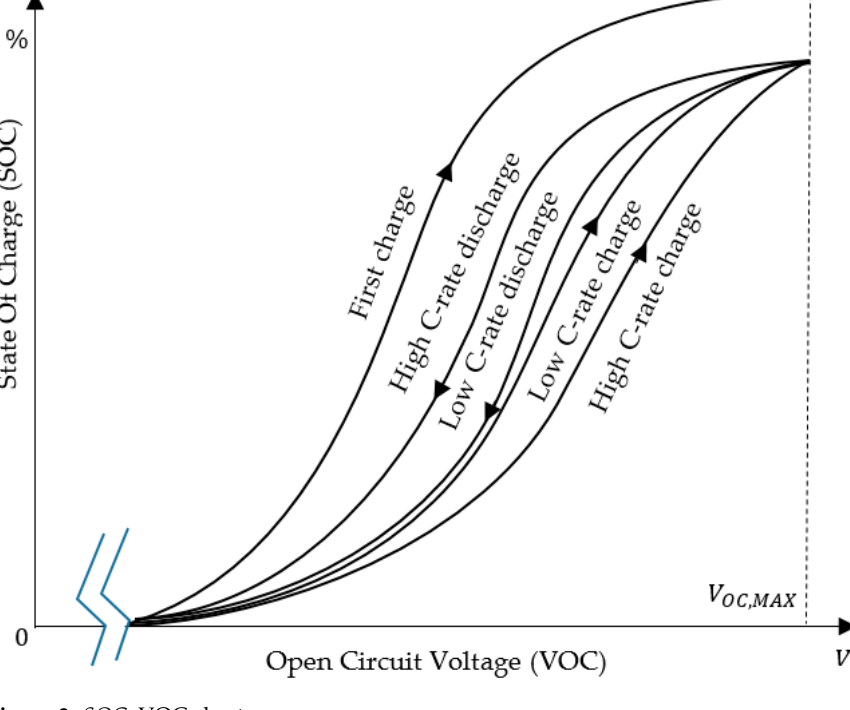
Figure 3. SOC –VOC chart.